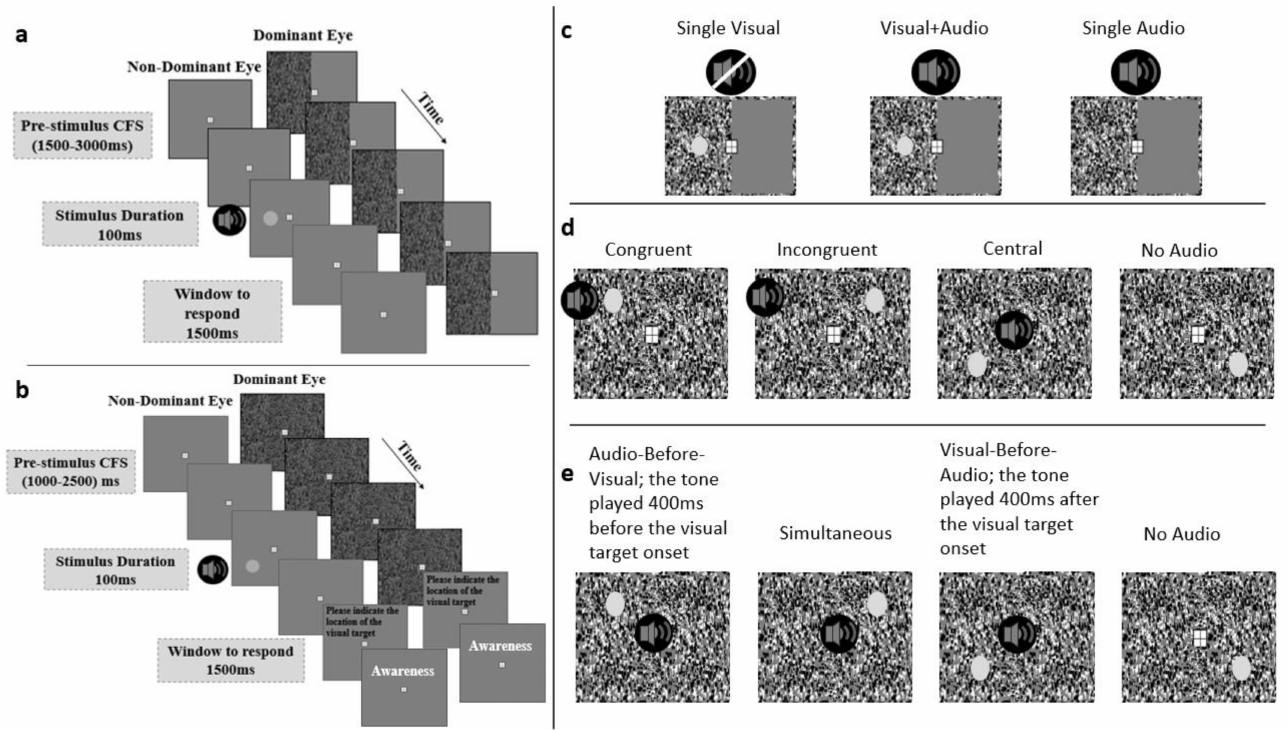
Figure 1. Schematic illustrations of the trial structure of experiment 1 ( a ), and experiments 2 and 3 ( b ). In ( c – e ), all conditions are listed from left to right. Experiment 1 had three conditions: Single Visual, Visual + Audio, and Single Audio ( c ). Experiment 2 had four conditions where the auditory tone and visual target locations were either: Congruent, Incongruent, non-informative audio (Central), or No Audio. Experiment 3 had four conditions: the auditory tone either preceded by 400 ms (Audio-Before- Visual), occurred simultaneously, or succeeded the visual target by 400 ms (Visual-Before-Audio), or the tone was absent (No